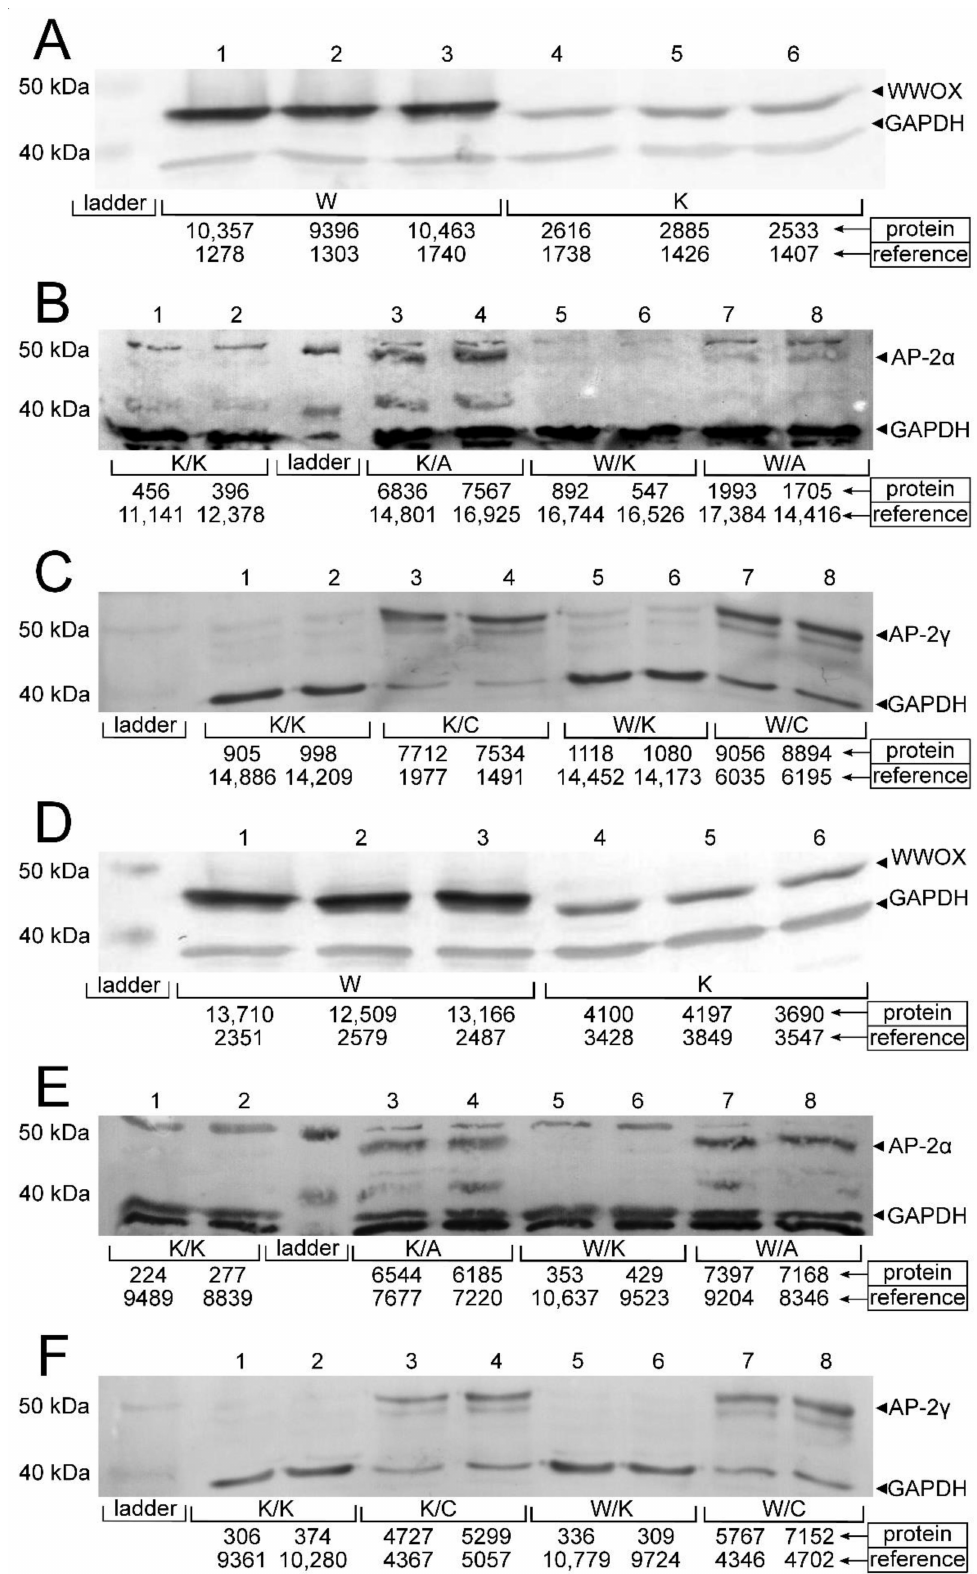
Figure 2. Verification of gene overexpression on the protein level. ( A ) WWOX overexpression in HT-1376. ( B ) AP-2 α overexpression in HT-1376. ( C ) AP-2 γ overexpression in HT-1376. ( D ) WWOX overexpression in CAL-29. ( E ) AP-2 α overexpression in CAL-29. ( F ) AP-2 γ overexpression in